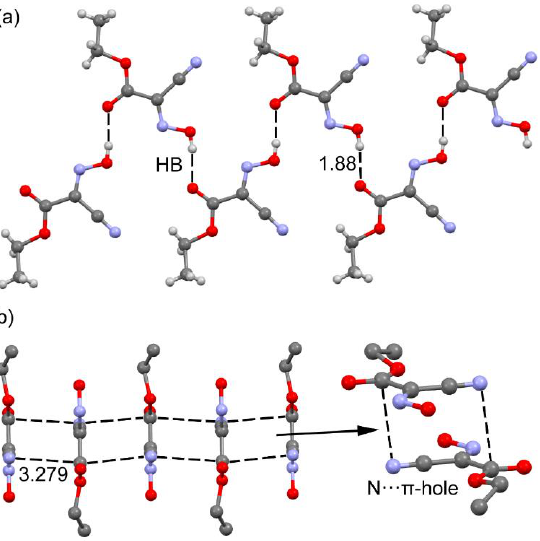
Figure 3. Partial view of the X-ray structure of Oxyma with indication of the H-bonds ( a ) and π–hole interactions ( b ). Distances in Å. The H-atoms have been omitted in ( b ) for clarity.